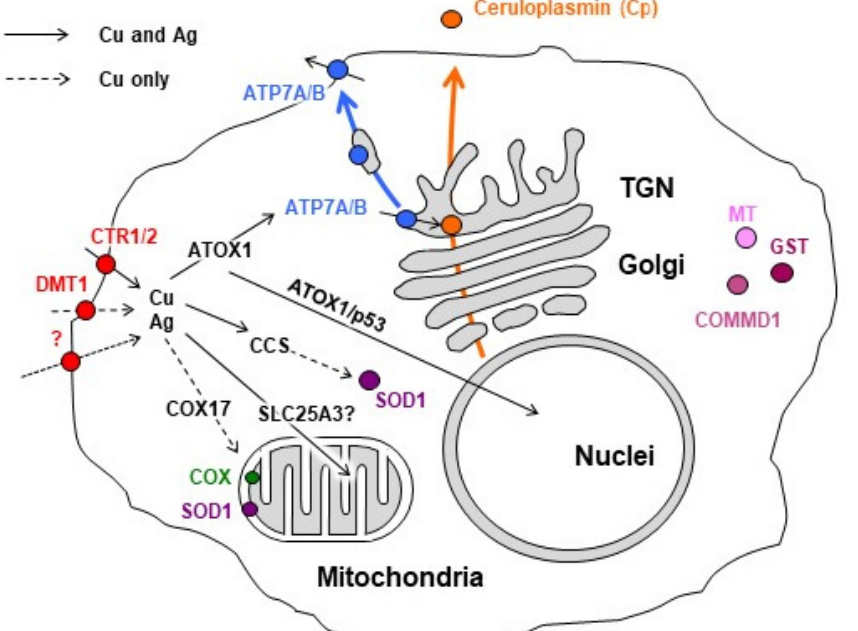
Figure 1. Scheme of copper and silver distribution in a mammalian hepatocyte. Copper is taken up via copper transporter 1 (CTR1), divalent metal transporter 1 (DMT1), or the putative transporter (all depicted as red circles). After being imported into the cell, the copper is transferred to chaperones antioxidant protein 1 (ATOX1), copper chaperone (CCS), and cytochrome- c -oxidase (COX17), which ferry it (black arrows) to both copper-transporting ATPase (ATP7A/B, blue) in the Golgi, to Cu,Zn-superoxide dismutase (SOD1, magenta) in the cytosol, and to cytochrome- c -oxidase (COX, green) in the mitochondria. Mitochondrial phosphate carrier protein (SLC25A3) transfers copper into the matrix. In the Golgi, ATP7A/B load Cu on newly synthesized cuproenzymes such as Ceruloplasmin (Cp, orange circle), which transport it along the biosynthetic pathway (orange arrow). A significant increase in intracellular Cu induces the export of ATP7A/B (blue arrow) toward the post-Golgi compartments (TGN) and plasma membrane, where it drives the excretion of excessive Cu from the cell. Copper Metabolism MURR1 domain protein 1 (COMMD1) protein is involved in copper transport and protein trafficking/degradation. Excessive Cu could be also bind by cysteine-rich peptides Metallothioneins (MTs, pink)—Silver uses similar copper-transporting routes (solid black arrows). However, several copper-transporting pathways cannot be invaded by silver (dashed black arrows). Scheme is modified from our article [49].